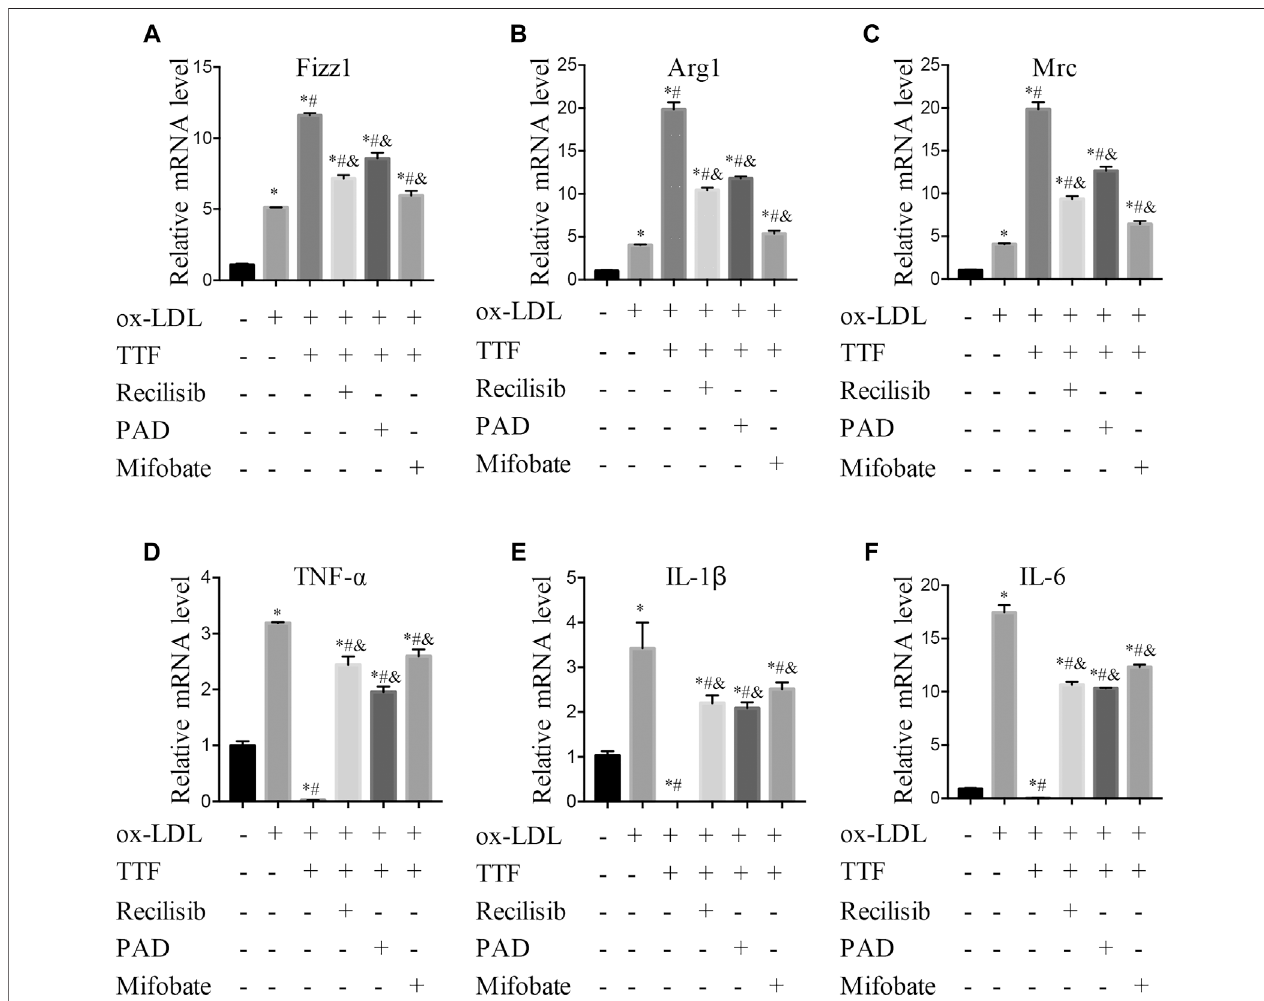
FIGURE 9 | TTF functions through promoting PPAR γ signal expression and inhibiting AKT/ERK pathway. PM cells were pretreated with 30 μ M AKT activator (Recilisib), 25 nM ERK activator (PAD), or 50 μ M PPAR γ inhibitor (Mifobate) for 1 h, then treated with 0.5 mg/ml TTF and 80 μ g/ml ox-LDL for 24 h. Total RNA was extractedandthenrelativemRNAlevelofFizz1 (A) ,Arg1 (B) ,Mrc (C) ,TNF- α (D) ,IL-1 β (E) ,andIL-6 (F) weredetectedbyq-PCR.Valuesarepresentedasmeans ± SEM (n (cid:2) 3 per group). * p < 0.05 vs group with ox-LDL only; # p < 0.05 vs group without ox-LDL and TTF; & p < 0.05 vs group with ox-LDL and TTF.